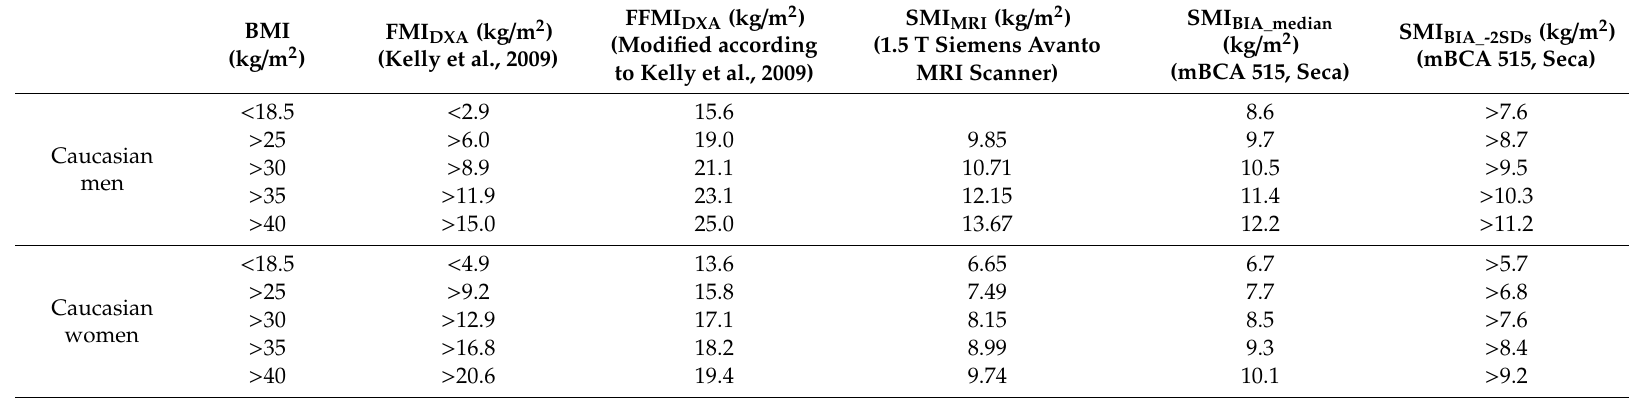
Table 5. Generation of cut-o ff s for SMI (corresponding to BMI thresholds) based on